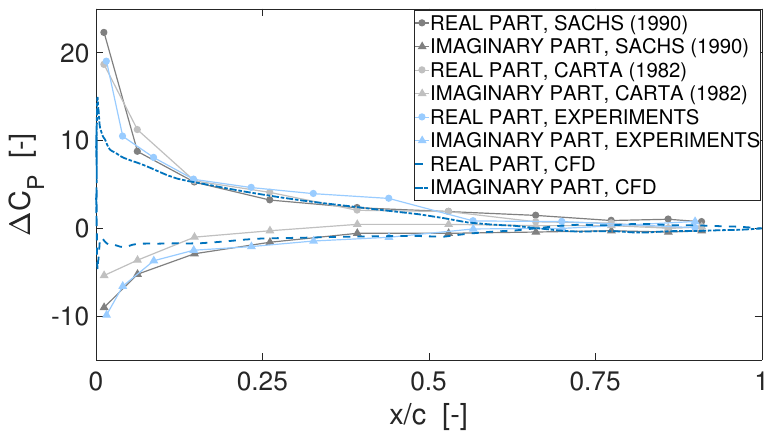
Figure 6. Real and imaginary part of unsteady pressure distribution. Experiments and CFD on the clean configuration; Re ∼ 350,000; IBPA = 0 deg.; α = 2 + sin ( 2 π f t + 4 × IBPA π t: